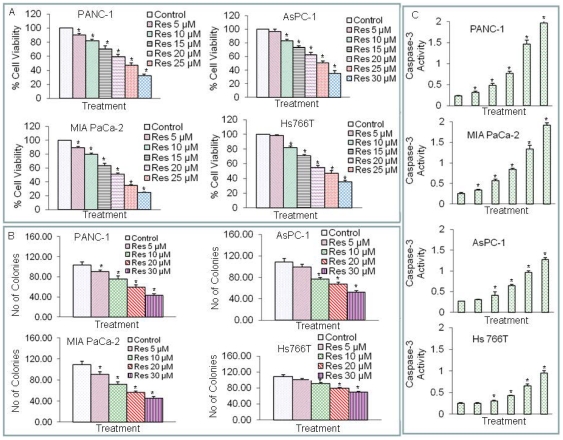
Effects of resveratrol on cell viability, colony formation and caspase-3 activity in pancreatic cancer cells.(A), Cell Viability. Pancreatic cancer (PANC-1, MIA PaCa-2, Hs766T and AsPC-1) cells were treated with resveratrol (0–30 µM) for 48 h. Cell viability was measured by XTT assay. Data represent the mean ± S.D. * = significantly different from respective controls, P<0.05. (B), Colony formation. Pancreatic cancer (PANC-1, MIA PaCa-2, Hs766T and AsPC-1) cells were treated with resveratrol (0–30 µM) for 3 weeks. At the end of incubation period, colonies were fixed and number of colonies were counted. Data represent the mean ± S.D. * = significantly different from respective controls, P<0.05. (C), Caspase-3 activity. Pancreatic cancer PANC-1, MIA PaCa-2, Hs 766T and AsPC-1 cells were treated with resveratrol (0–40 µM) for 24 h and caspase-3 activity was measured as per manufacturer's instructions (EMD Biosciences). Data represent the mean ± S.D. * = significantly different from respective controls, P<0.05.